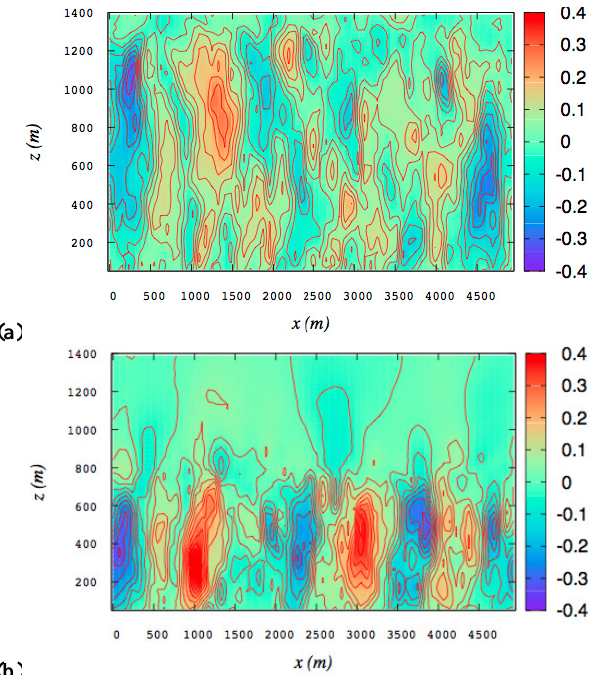
Fig. 11. A vertical cut of the fluctuating vertical velocity, averaged over the y direction. (a) is a snapshot recorded from the LES at 12:00UTC before subsidence is turned on; while (b) refers to a snapshot recorded at the end of the run, at 15:30UTC.